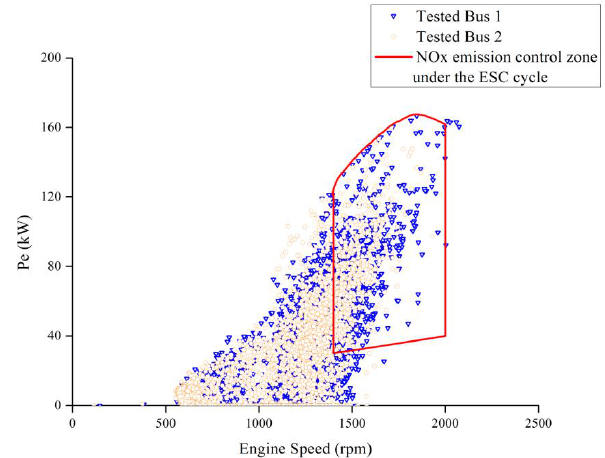
Fig. 7. The map of real-time engine speed and derived engine power (Pe) of two tested Euro IV buses. Inside the red frame box means the NO x emission control zone under the certificated ESC cycle.